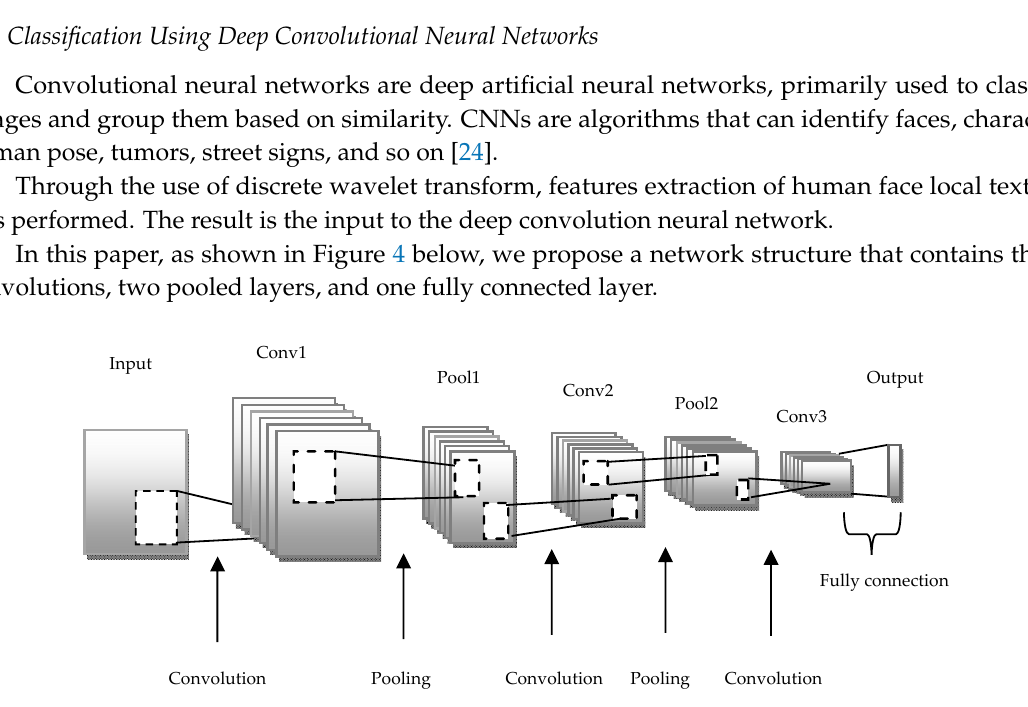
Figure 3. Multilevel wavelet decomposition consists of the following: ( a ) single level components specification, ( b ) two-level components specification, ( c ) discrete wavelet transform (DWT) single level, and ( d ) DWT two-level decomposition. LH—vertical; HL—horizontal; HH—diagonal detail.